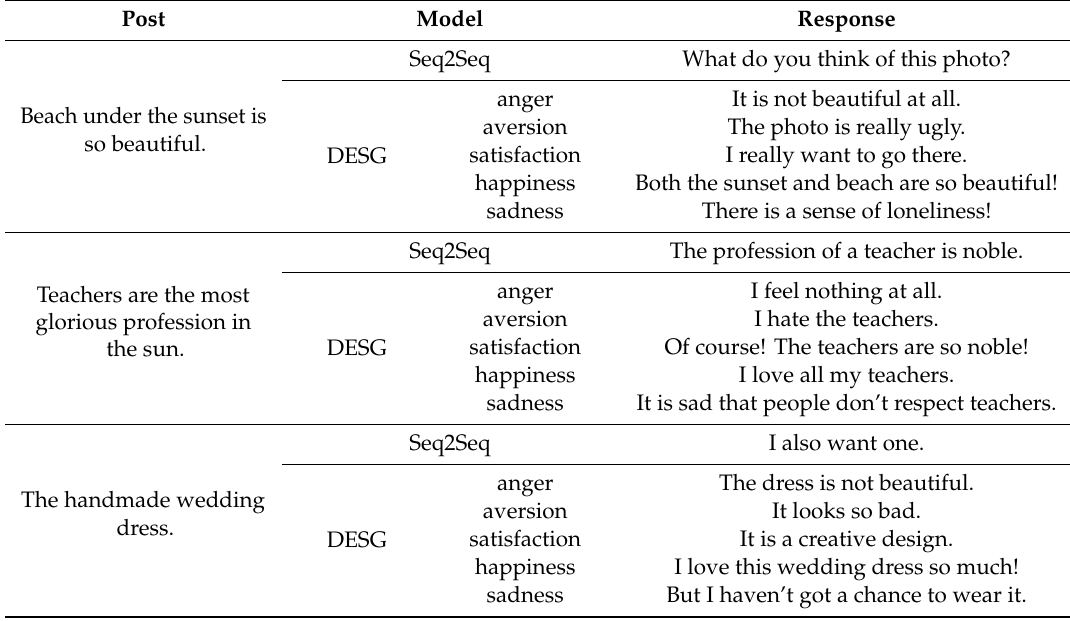
Table 6. Case study for DESG.